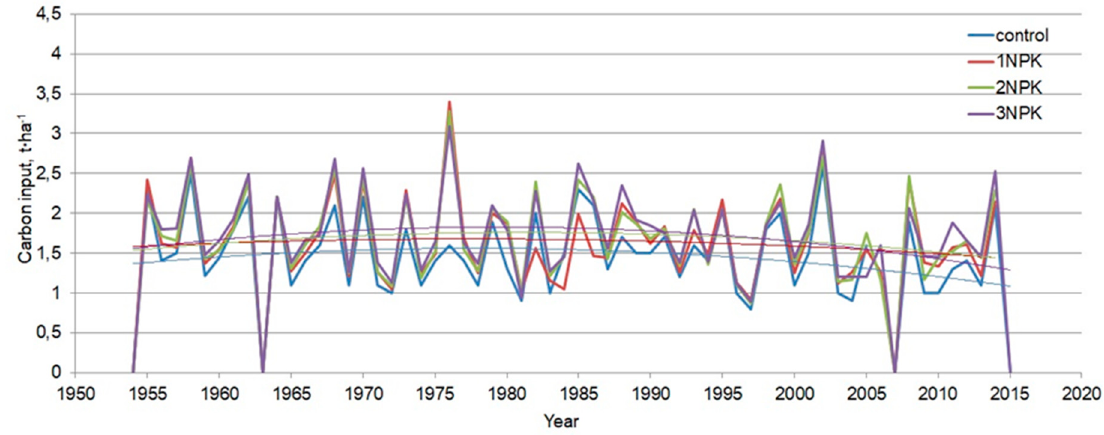
Figure 2. The annual C input in the long-term field experiment of VNIISS only with plant residues. On the axis of abscissas—the input according to crop-specific biomass allocation coefficients of organic C, t·ha − 1 with stubble and belowground biomass, on the axis of ordinate—the year of input. Smoothing was performed using second-degree polynomials. Zero input corresponds to fallows.